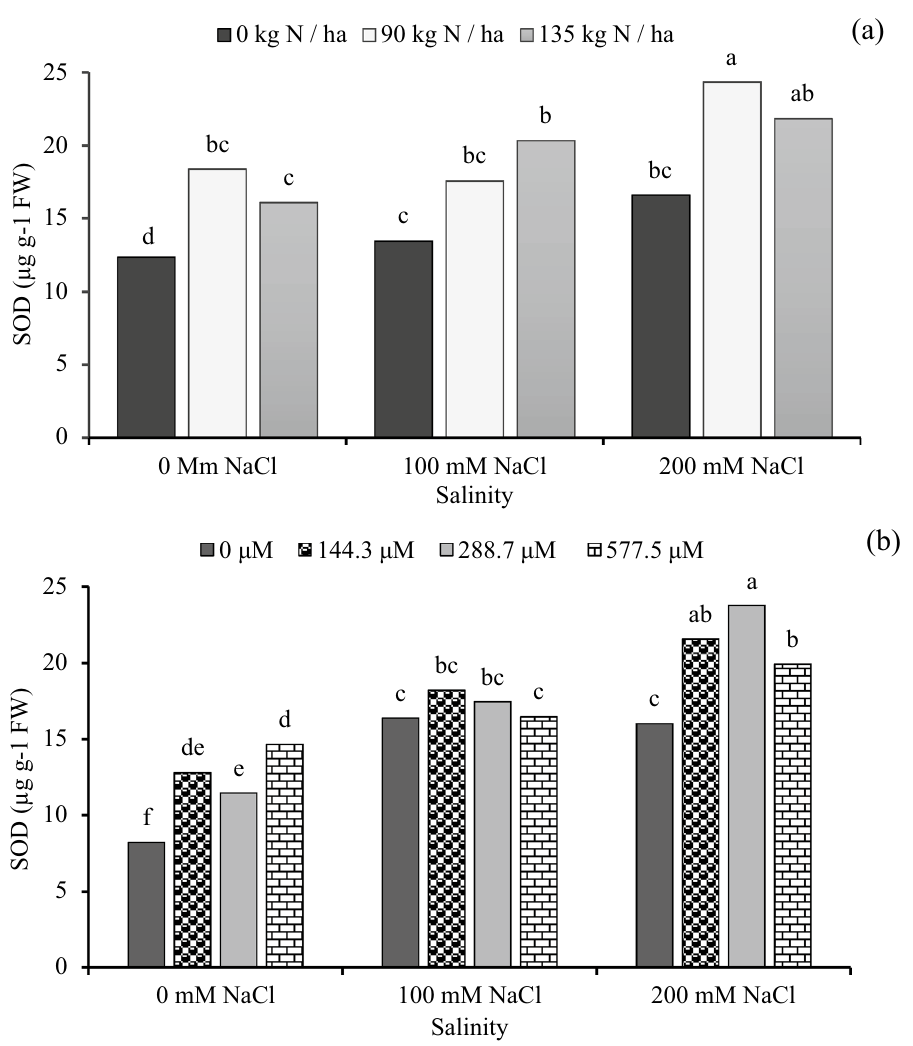
Figure 4. The effect of interaction between: ( a ) different concentrations of salinity × different concentrations of nitrogen and ( b ) different concentrations of salinity × different concentrations of gibberellic acid (GA 3 ) on SOD of sorghum seedling. Bars with different letters are significantly different at the 0.05 probability. Means were separated by the LSD